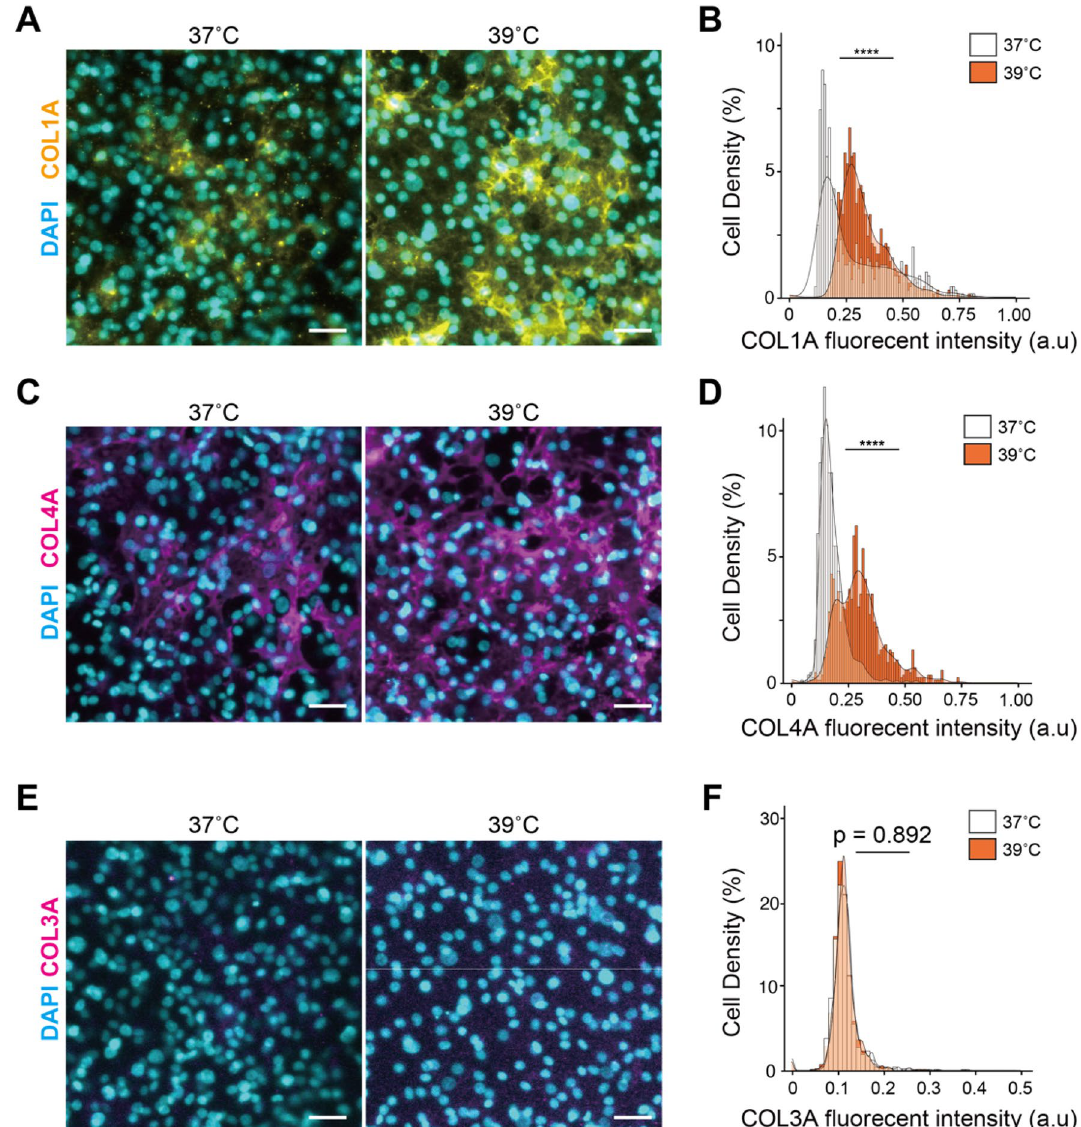
Figure 5. Evaluation of expression of collagen type I (COL1A), collagen type IV (COL4A), and collagen type III (COL3A) in hESC-HLCs with heat treatments. ( A,B ) Immunofluorescent micrographs ( A ) and single-cell profiling ( B ) of COL1A in 37 °C- and 39 °C-treated hESC-HLCs at 12 d.a.h. (n = 3). ( C,D ) Immunofluorescent micrographs ( C ) and single-cell profiling ( D ) of COL4A in 37 °C- and 39 °C-treated hESC-HLCs at 12 d.a.h. (n = 3). ( E,F ) Immunofluorescent micrographs ( E ) and single-cell profiling ( F ) of COL3A in 37 °C- and 39 °C-treated hESC-HLCs at 12 d.a.h. (n = 3). In all panels, where applicable, center lines of box plots indicate medians; box limits indicate the 25th and 75th percentiles as determined by R software; whiskers extend 1.5 times the interquartile range from the 25th and 75th percentiles; **** p < 0.0001; each plot and error bar represents a mean ± SD. DAPI was used for nuclei staining. Scale bars = 50